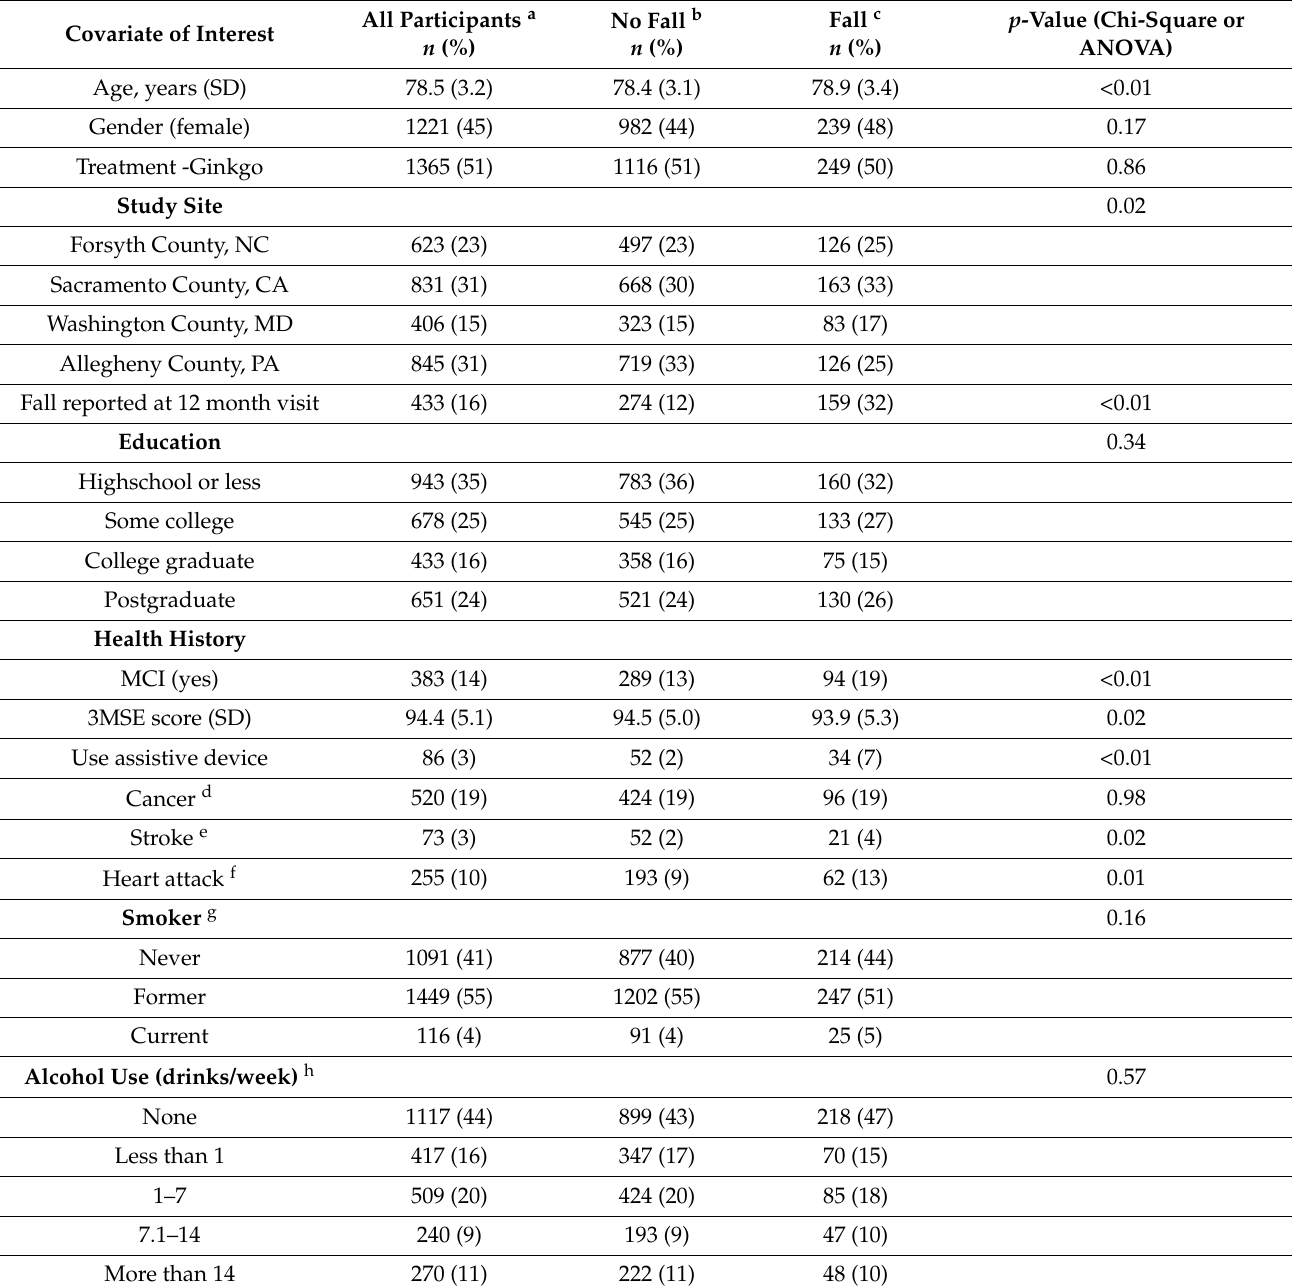
Table 2. Participant characteristics by fall status at 18-month study visit, Ginkgo Evaluation of Memory study (GEMS) ( n = 2705). Covariate of